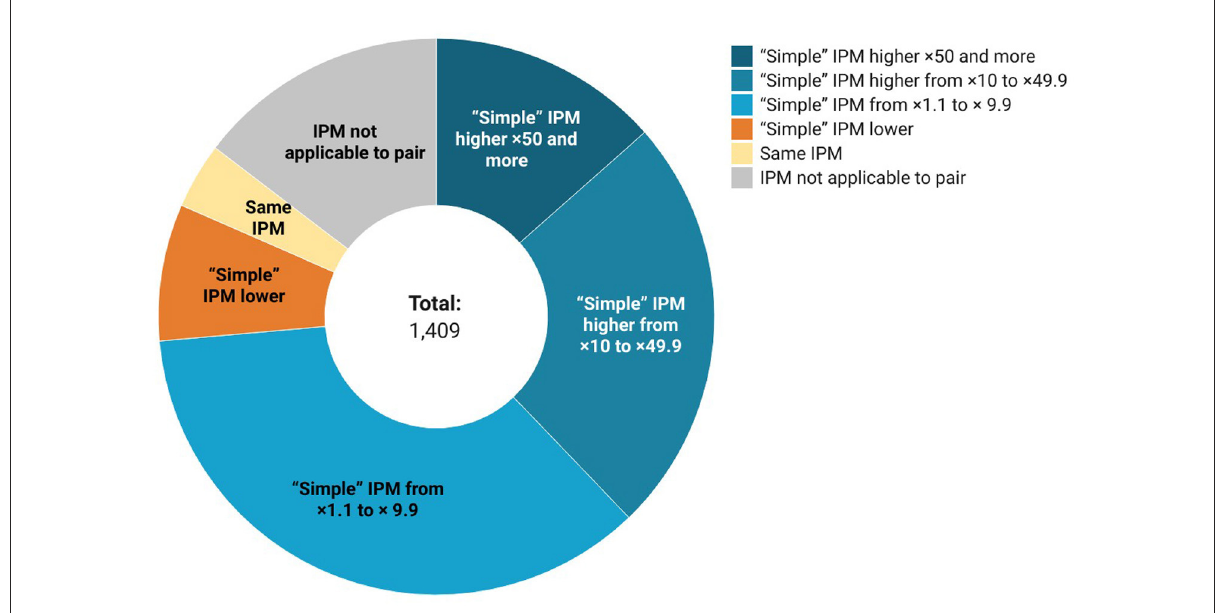
FIGURE3 Frequency